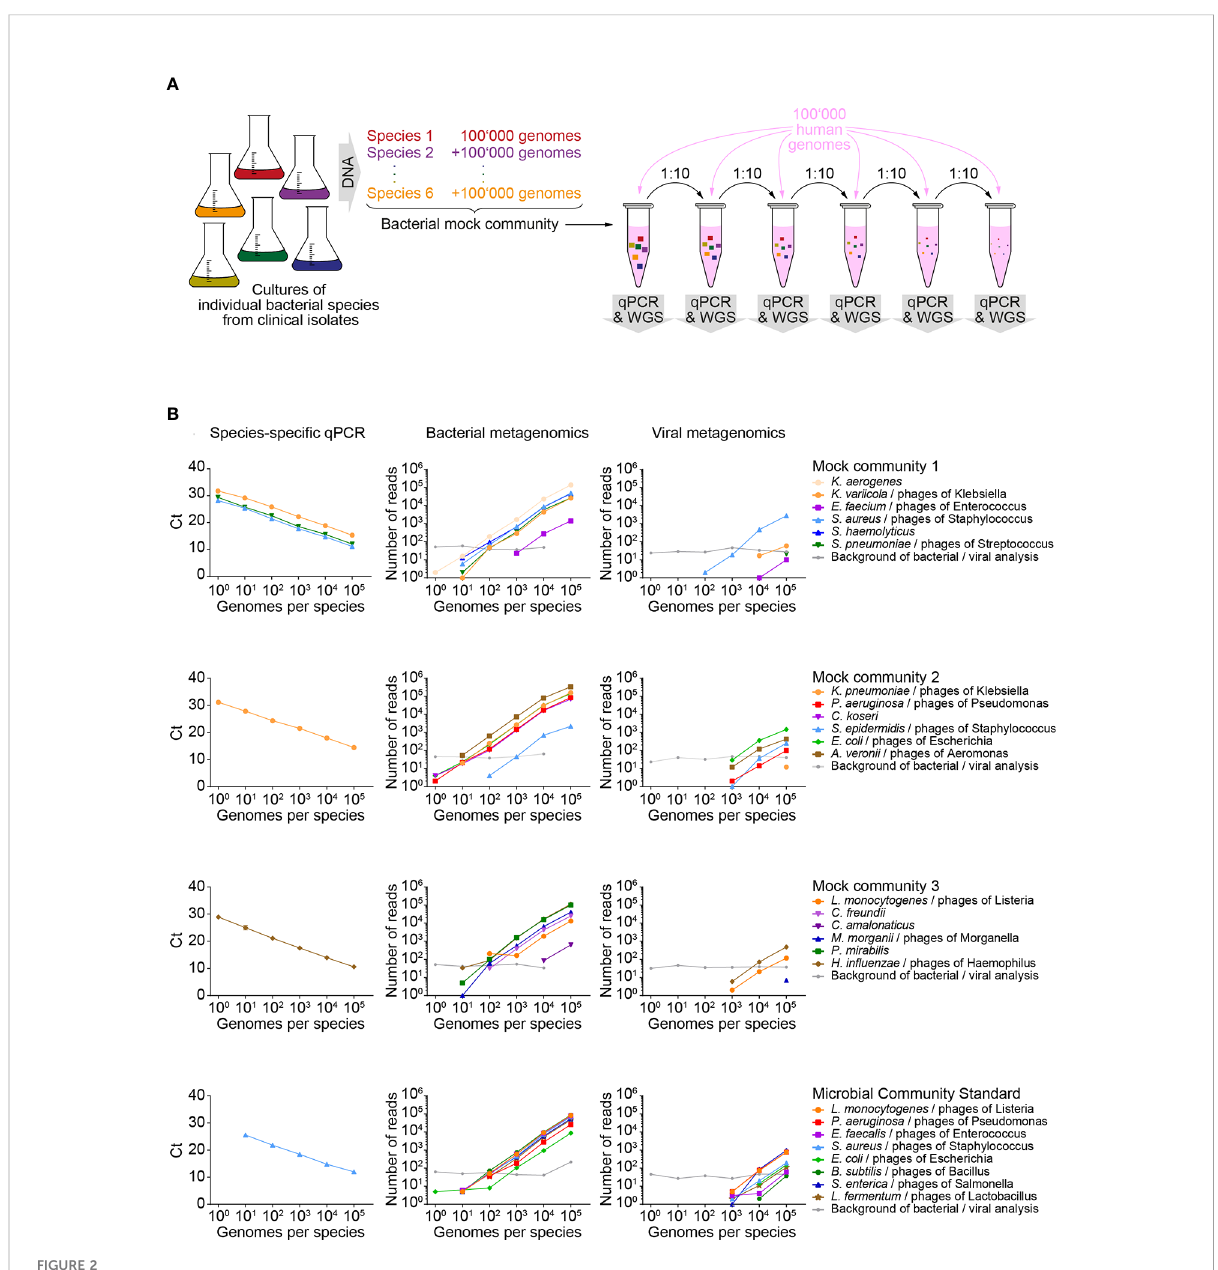
FIGURE 2 Sensitivity of metagenomics analysis on test samples of known composition. (A) Schematic work fl ow for generating serial dilutions of known bacterial pathogens (mock communities), admixed with human genomic DNA. (B) Detection of known bacterial pathogens and associated phages in diluted mock communities and detection of reference strains in a microbial community standard by quantitative PCR (qPCR, left column of panels), taxonomic pro fi ling for bacteria (middle column of panels) and viruses (right column of panels). Each row of panels represents results of an individual mock community represented by several dilutions. Within a row of panels, line color and symbol shape indicate data originating from a speci fi c isolate or reference species. Background of bacterial/viral analysis: The most abundant background signal detected for a bacterial and a viral species is indicated. WGS, whole genome sequencing; Ct, cycle